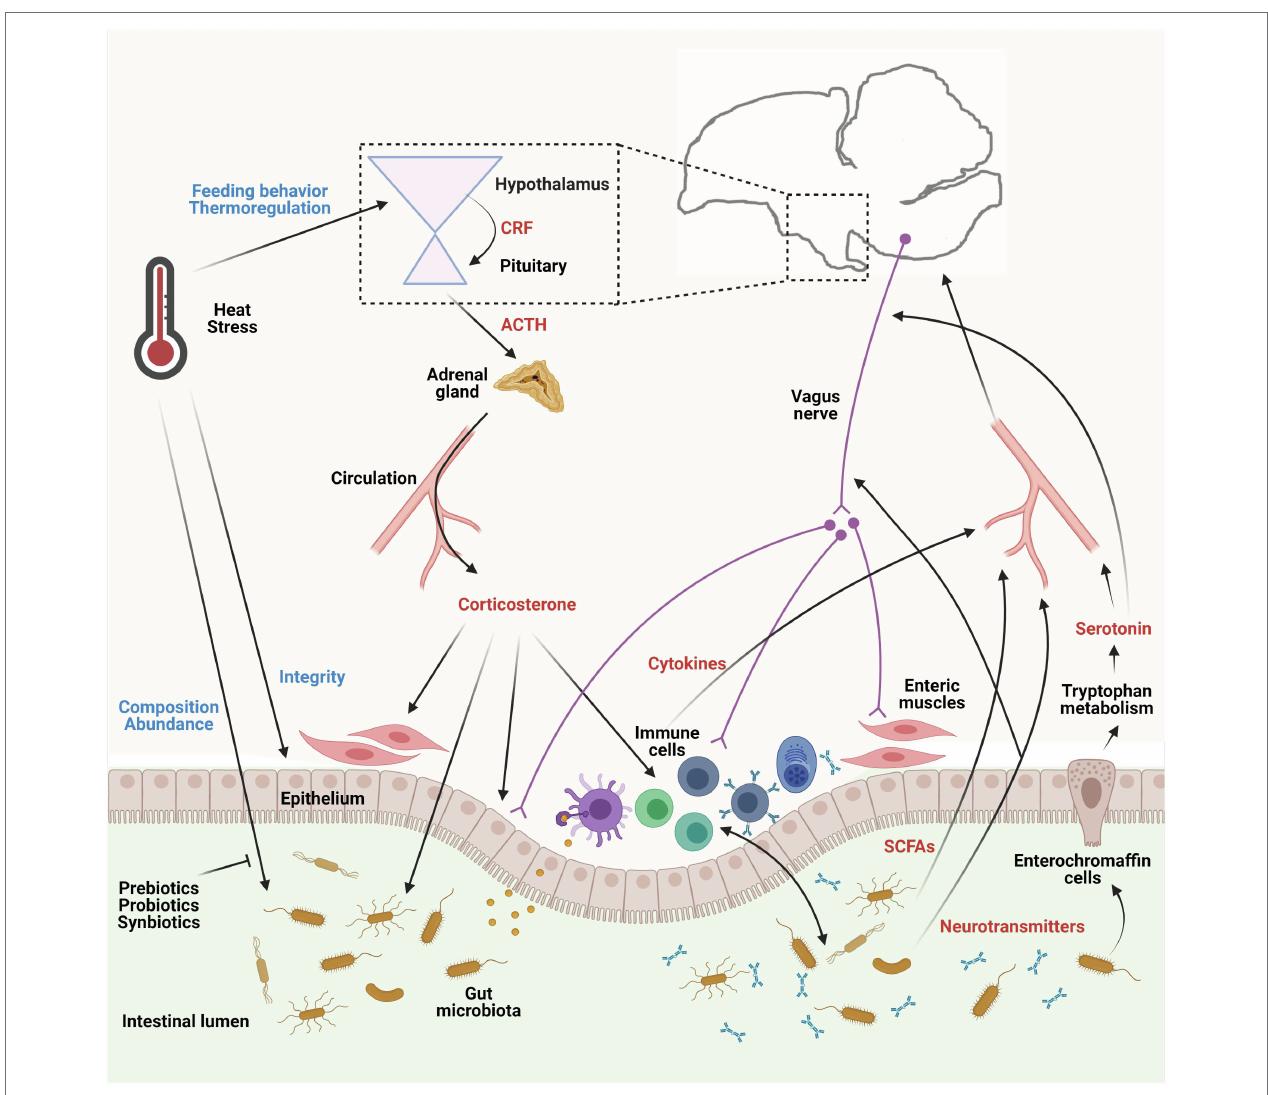
FIGURE 1 | Influences of heat stress on the microbiota-gut-brain axis (MGBA) and the pathways involved in the axis in chicken. The gut microbiota communicates with the gut-brain axis through several pathways, including neural, immune, and endocrine signaling. The gut microbiome produces neurotransmitters, such as serotonin, which can trigger responses of the vagus and enteric nervous system, and short-chain fatty acids (SCFAs), which can nourish the host and regulate the host’s brain activity and behaviors. Gut microbiota also stimulates intestinal immune cells to generate and secrete cytokines to induce immune response locally and systemically and modulate the brain. In turn, the brain utilizes the same pathways to alter the gut microbiota, especially their composition and abundance, under circumstances, such as heat stress. Heat stress can influence the MGBA both directly and indirectly. The hypothalamic-pituitary-adrenal axis is activated by heat stress and facilitates the production of corticosterone in birds, which further affects enteric cells and gut microbiota. The utilizations of prebiotics, probiotics, or symbiotics are promising approaches to alleviate the adverse effects of heat stress. ACTH, adrenocorticotropic hormone; CRF, corticotropin-releasing factor. This figure is adapted from previous publications (Cryan and Dinan, 2012; Aoki et al., 2017) and created with